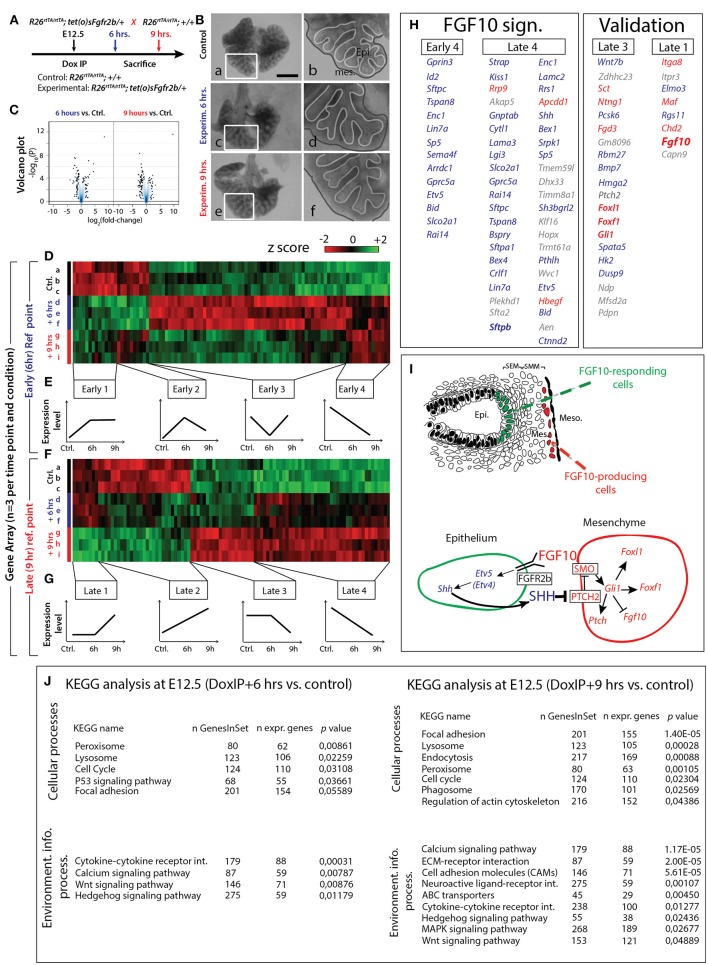
Identification of early FGF10 target genes by a gene array approach (A) E12.5 littermate control and experimental lungs were collected 6 or 9 h after a single Dox-IP injection to pregnant females. (B) FGFR2b signaling attenuation leads to visible branching defects at Dox-IP+9 h (increased mesothelial-epithelial distance and branching inhibition). Meso.=Mesothelium; Epi.=Epithelium. Scale bar: (a,c,e) 500 μm; (b,d,f) 175 μm. (C) Volcano plots showing genes which are either down- or up-regulated at 6 or 9 h Dox-IP compared to the time-matched control lungs. (D) Heatmap of the top 100 genes differentially expressed between experimental and control lungs at 6 hrs (based on p-values). (E) Four classes of genes, grouped according to expression pattern (Early 1–4). (F) Heatmap of the top 100 genes differentially expressed between experimental and control lungs at 9 h (based on p-values). (G) Four classes of genes, grouped according to expression pattern (Late 1–4). (H) Genes identified in the Early 4 and Late 4 clusters are direct targets of FGF10 signaling and comprise the “FGF10 gene signature.” Many genes in the Late 3 and Late 1 clusters are involved in the FGF10/SHH regulatory feedback loop (see I), validating the gene array approach (note the presence of Fgf10 in the Late 1 cluster). Genes enriched in the epithelium or mesenchyme are color coded in blue or red, respectively. (I) Reconstitution of the FGF10-FGFR2b-ETV4/5-SHH-FGF10 signaling axis from the gene array. (J) KEGG results for 6 and 9 h Dox-IP vs. control. [(D,F)
n = 3; see Materials and Methods for details on the statistical analysis of gene arrays].